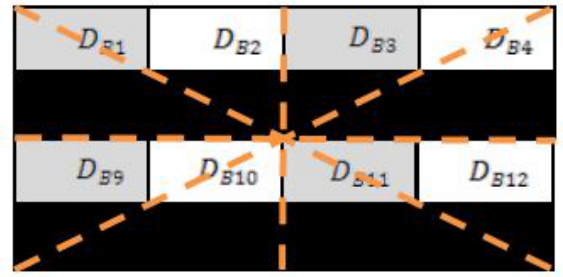
Fig. 3. The proposed 4 × 4 interpolation